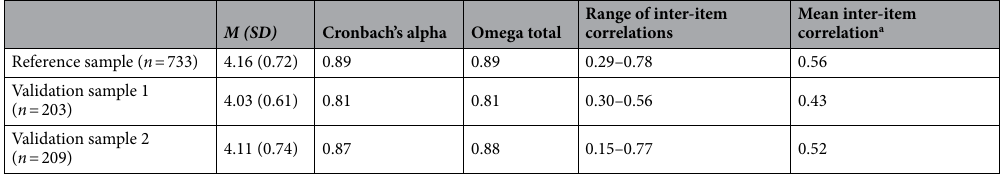
Table 1. Descriptive and reliability statistics for the Polish RAS. RAS Relationship Assessment Scale. a The mean inter-item correlation of the original RAS was determined to be 0.49 (Hendrick 6